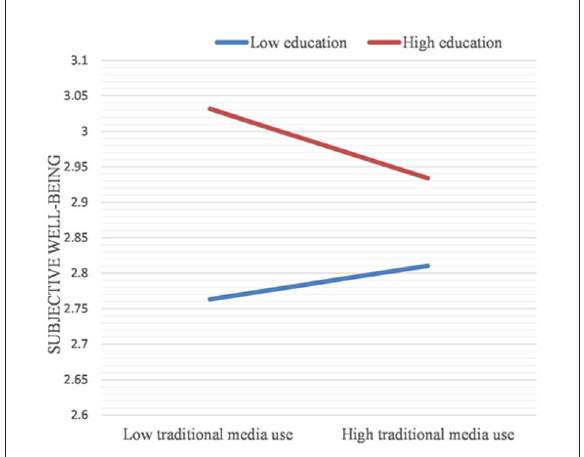
FIGURE1 Simple slope plot for the interaction between traditional media use and education (Dependent variables: Self-rated health).